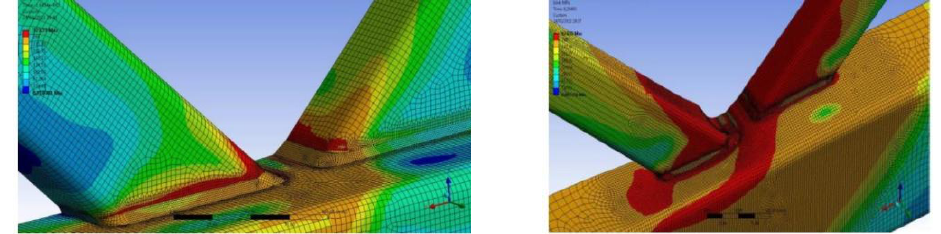
Figure 8. Von Mises stresses in the simulation of the K-joint.